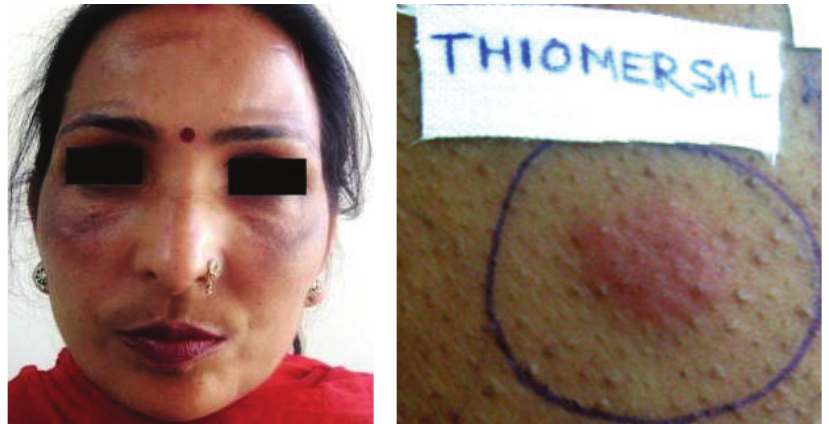
Figure 5: A patient with centrofacial melasma and positive reaction from thiomersal.